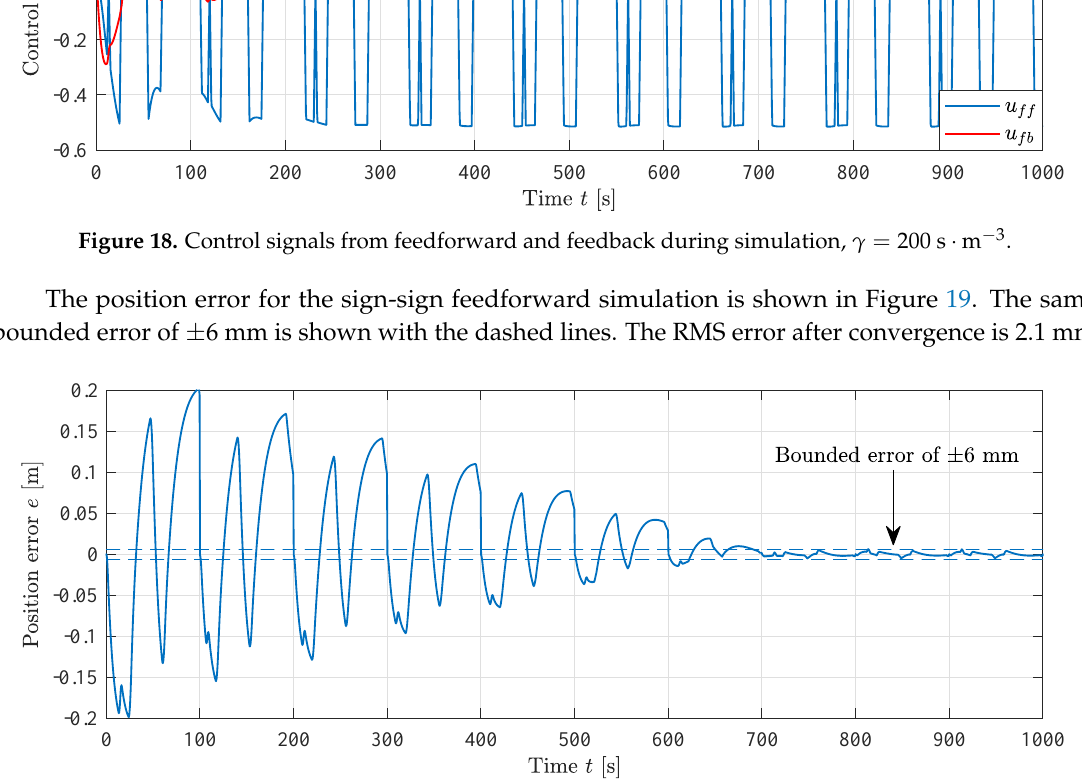
Figure 19. Cylinder position error during sign-sign feedforward simulation, γ = 0.1 m − 1 . The states z f f for the sign-sign feedforward simulation are shown in Figure 20. The dashed lines